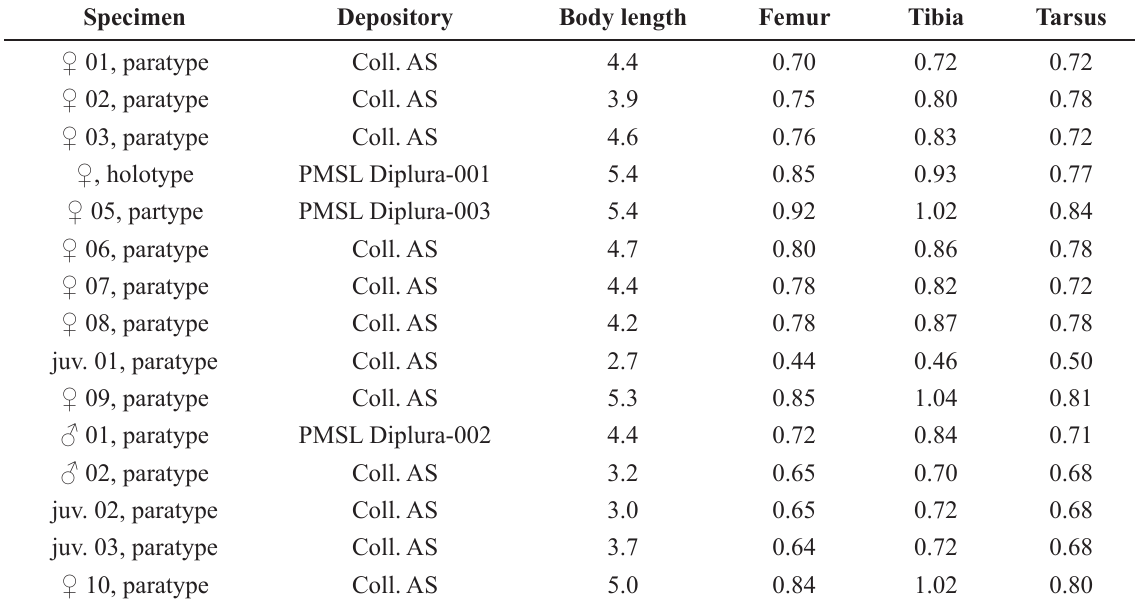
Table 12. Plusiocampa ( Plusiocampa ) ternovensis Sendra & Borko sp. nov. Length of the body, femur, tibia and tarsus (including pretarsus) (measurements in